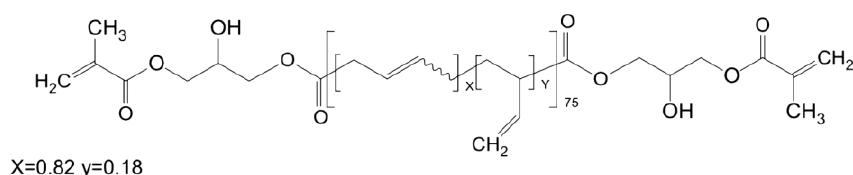
Figure 2. Chemical structure of methacrylate-functional liquid synthetic rubber used as a toughening agent.